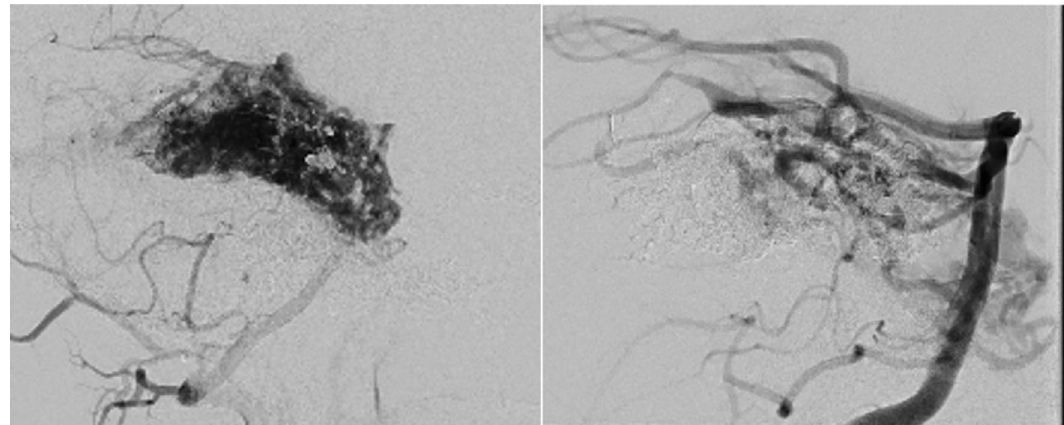
Fig. 7 DSA images before (left) and after (right) of embolization via PCT with Kaneka coil wedge in lateral view